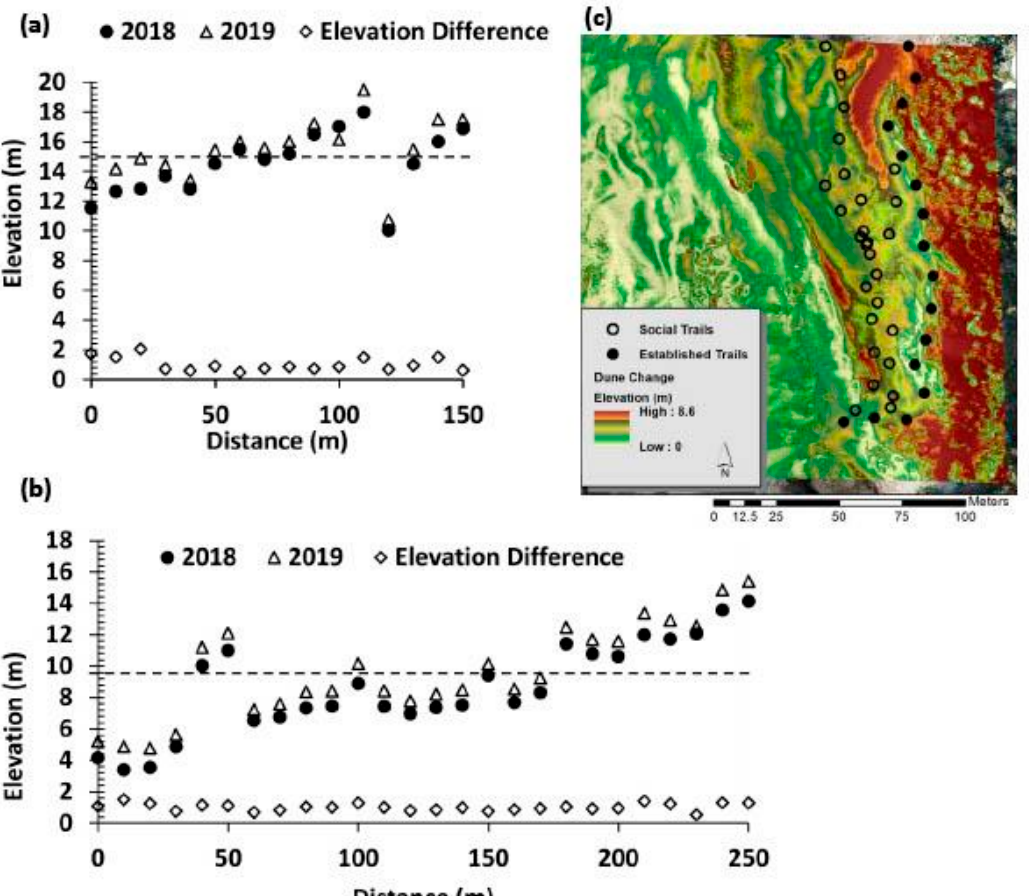
Figure 6. Comparison of elevation changes for the established trails ( a ) and social trails ( b ) extracted from registered 0.12-m digital elevation model (DEMs) from 2018 to 2019 along 10-m intervals. The trails were selected backdunes where the start and end points were in proximity to each other ( c ). The mean elevation change was given in a dash line.